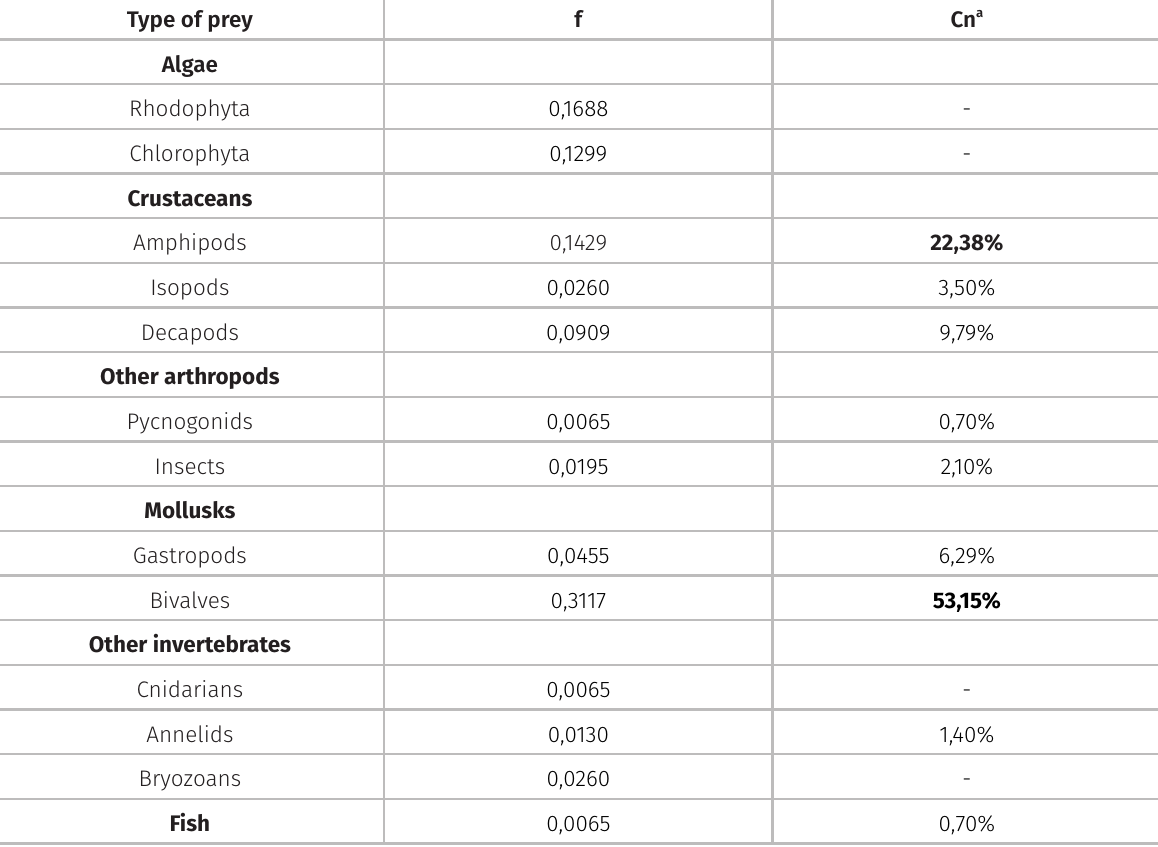
Table I. Prey items in Bunodosoma zamponii . Frequency index of prey (f) and percentage of prey (Cn) of the different food sources in the total gastral cavities of B. zamponii analyzed. The values in bold indicate major and minor prey (the other values correspond to occasional food